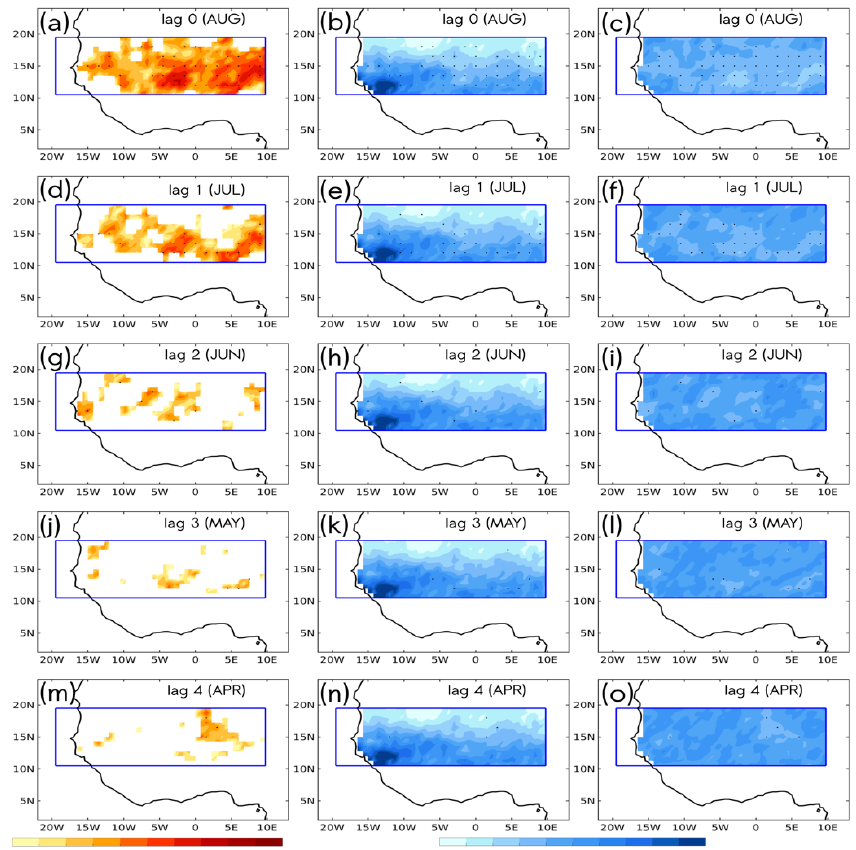
western Sahel compared to the surrounding regions.